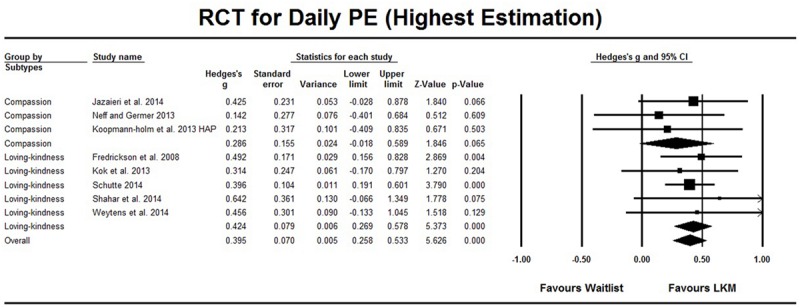
Randomized control trail (RCT) studies on daily PE, comparison with waitlist control group. The highest estimation was based on high arousal positive (HAP) emotion in Koopmann-Holm et al. (2013). Subgroup analysis compared LKM on loving-kindness and LKM on compassion.